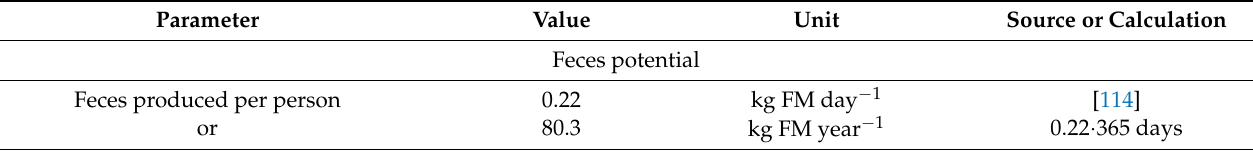
Table A3. Calculation of the P recycling potential for the TC-F composting process in the city of Berlin, Germany. Parameter